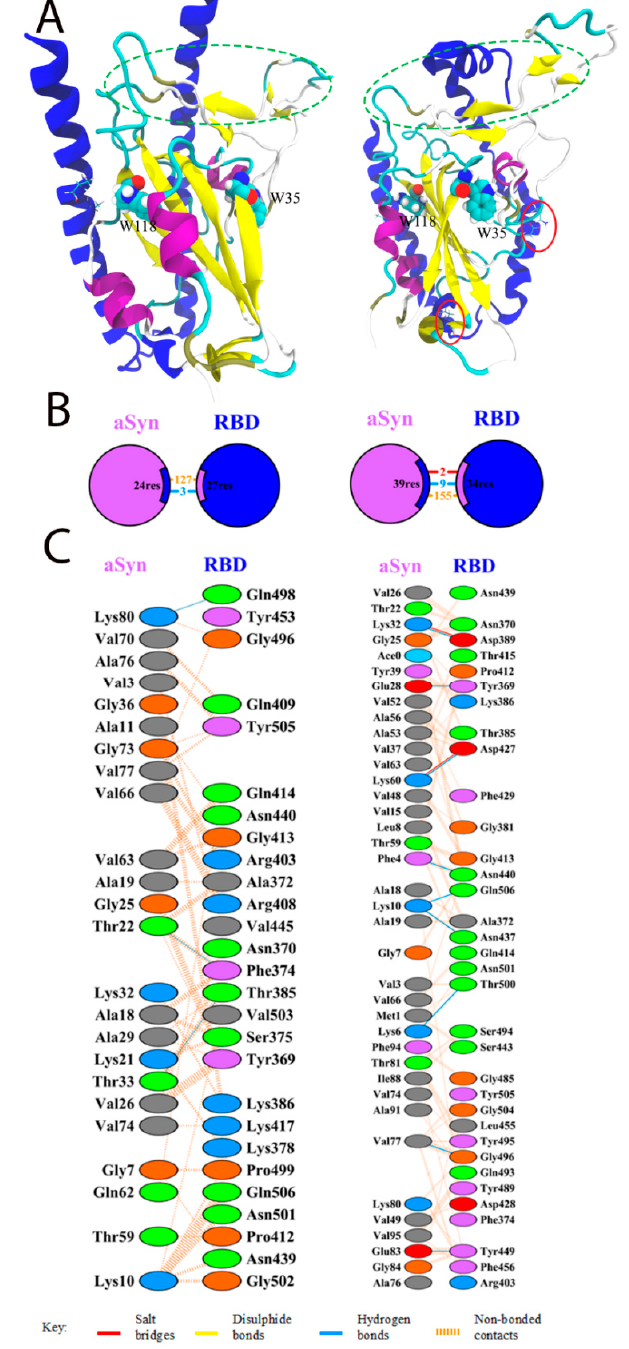
Figure 1. Interaction of SARS-CoV-2 RBD with alpha-synuclein by docking ( left ) or after 100 ns of molecular dynamics ( right ). ( A ) General view of binding. Alpha-synuclein is stained blue. RBD: α -helices are stained violet; β -sheets are yellow; the unstructured part is cyan. Tryptophan residues are highlighted on the RBD; the interaction site with ACE2 is highlighted with green ovals. On the alpha-synuclein as Licorice, residues within 5 Å of tryptophan residues are marked. Red ovals indicate the salt bridges formed during the dynamic simulation. ( B ) Schematic representation of the interaction of RBD with alpha-synuclein. Numbers indicate the amount of salt bridges (red), non-bonded contacts (orange), and hydrogen bonds (blue) that were discovered by docking ( left ) and molecular dynamics ( right ). ( C ) Residues involved in the interaction.( left ): docking; ( right ): molecular